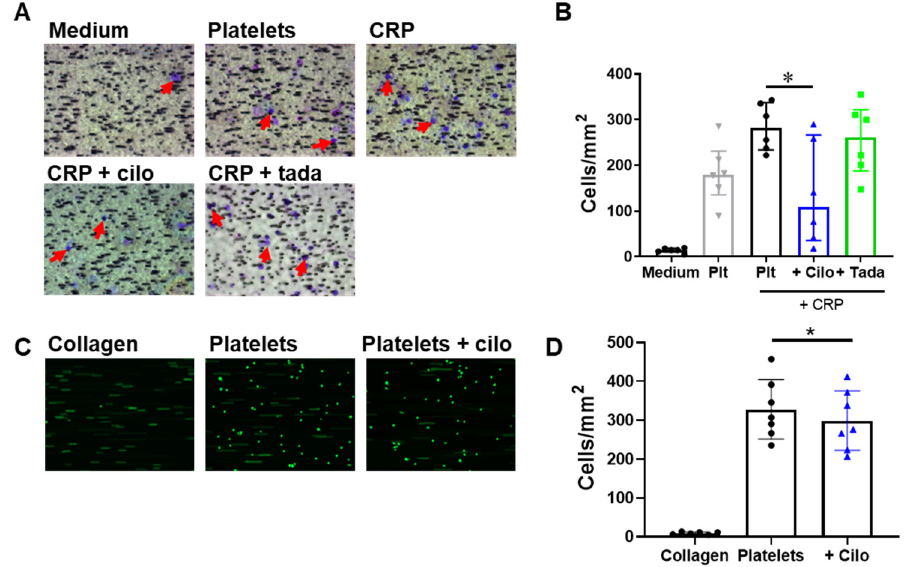
Figure 4. PDE3A inhibition decreases platelet-induced migration and platelet-induced adhesion of THP-1 cells under flow. Representative images ( A ) and quantitative analysis ( B ) of THP-1 cell migration to medium and to washed platelets, untreated or additionally stimulated with CRP and inhibited with cilostazol (5 μ M) or tadalafil (10 nM). Red arrows indicate THP-1 cells. Representative images ( C ) or quantitative analysis ( D ) of THP-1 adhesion to collagen alone, and to washed platelets in the absence or presence of cilostazol (5 μ M). Interquartile range ( B ), mean ± S.D. ( D ), n = 6 ( A , B ) or 7 ( C , D ), * p < 0.05. Statistics: Kruskal–Wallis test followed by Dunn’s multiple comparisons test ( B ) and Wilcoxon matched-pairs signed rank test ( D ). Cilo, cilostazol; CRP, collagen-re- lated peptide; plt, platelets; tada, tadalafil.